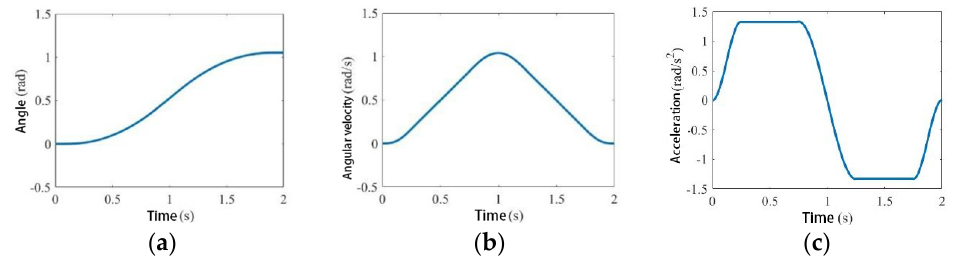
Figure 16. Angle, angular velocity and angular acceleration of joint 3.